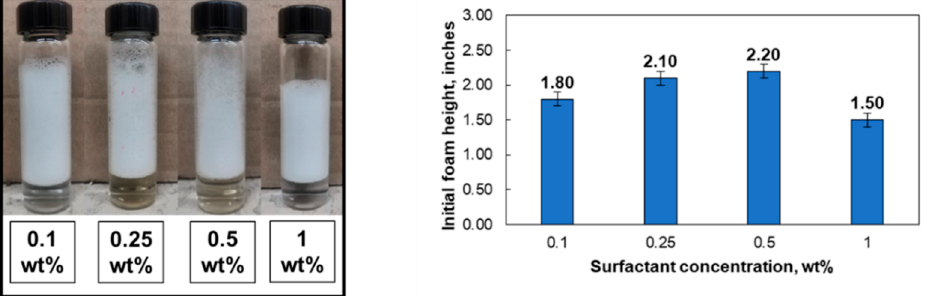
Figure 5. Effect of surfactant concentration on the initial foamability at 5 wt% NaCl, pH 6.5, and 77 °F (25 °C).